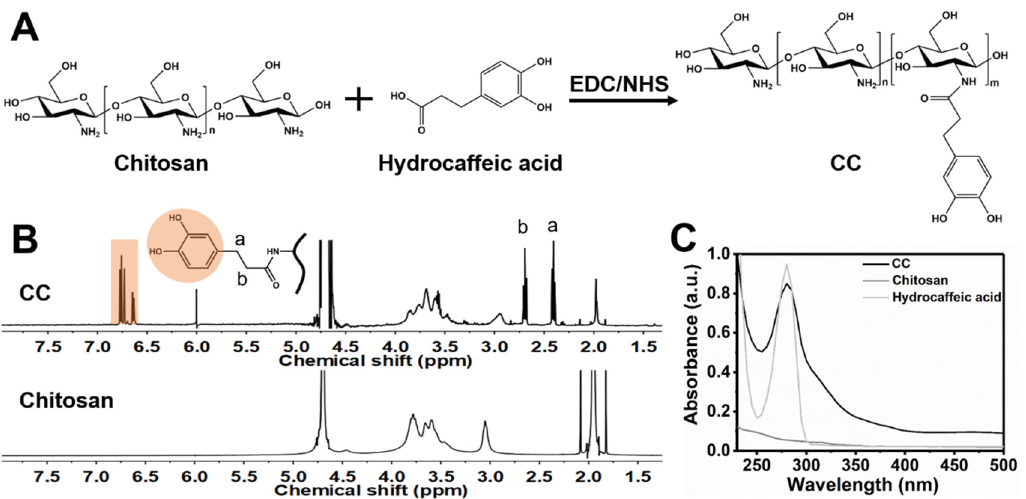
Figure 1. Synthesis and characterization of chitosan–catechol (CC). ( A ) The synthetic procedure of CC using EDC/NHS chemistry to conjugate hydrocaffeic acid with chitosan. ( B ) 1 H NMR spectra of CC and chitosan. ( C ) UV–vis spectra of CC solution, chitosan solution, and hydrocaffeic acid solution in the range of 200 nm to 500 nm.